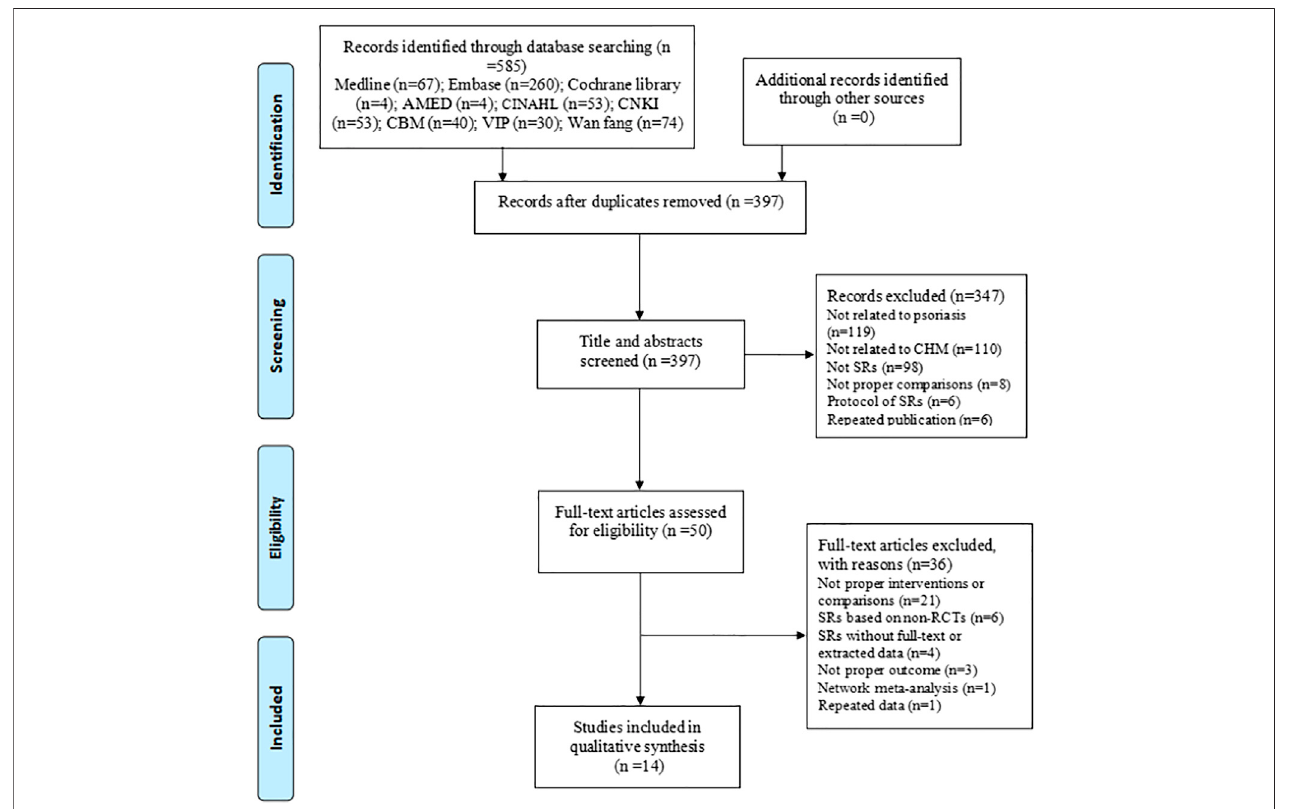
FIGURE 1 | Flow diagram of the study selection